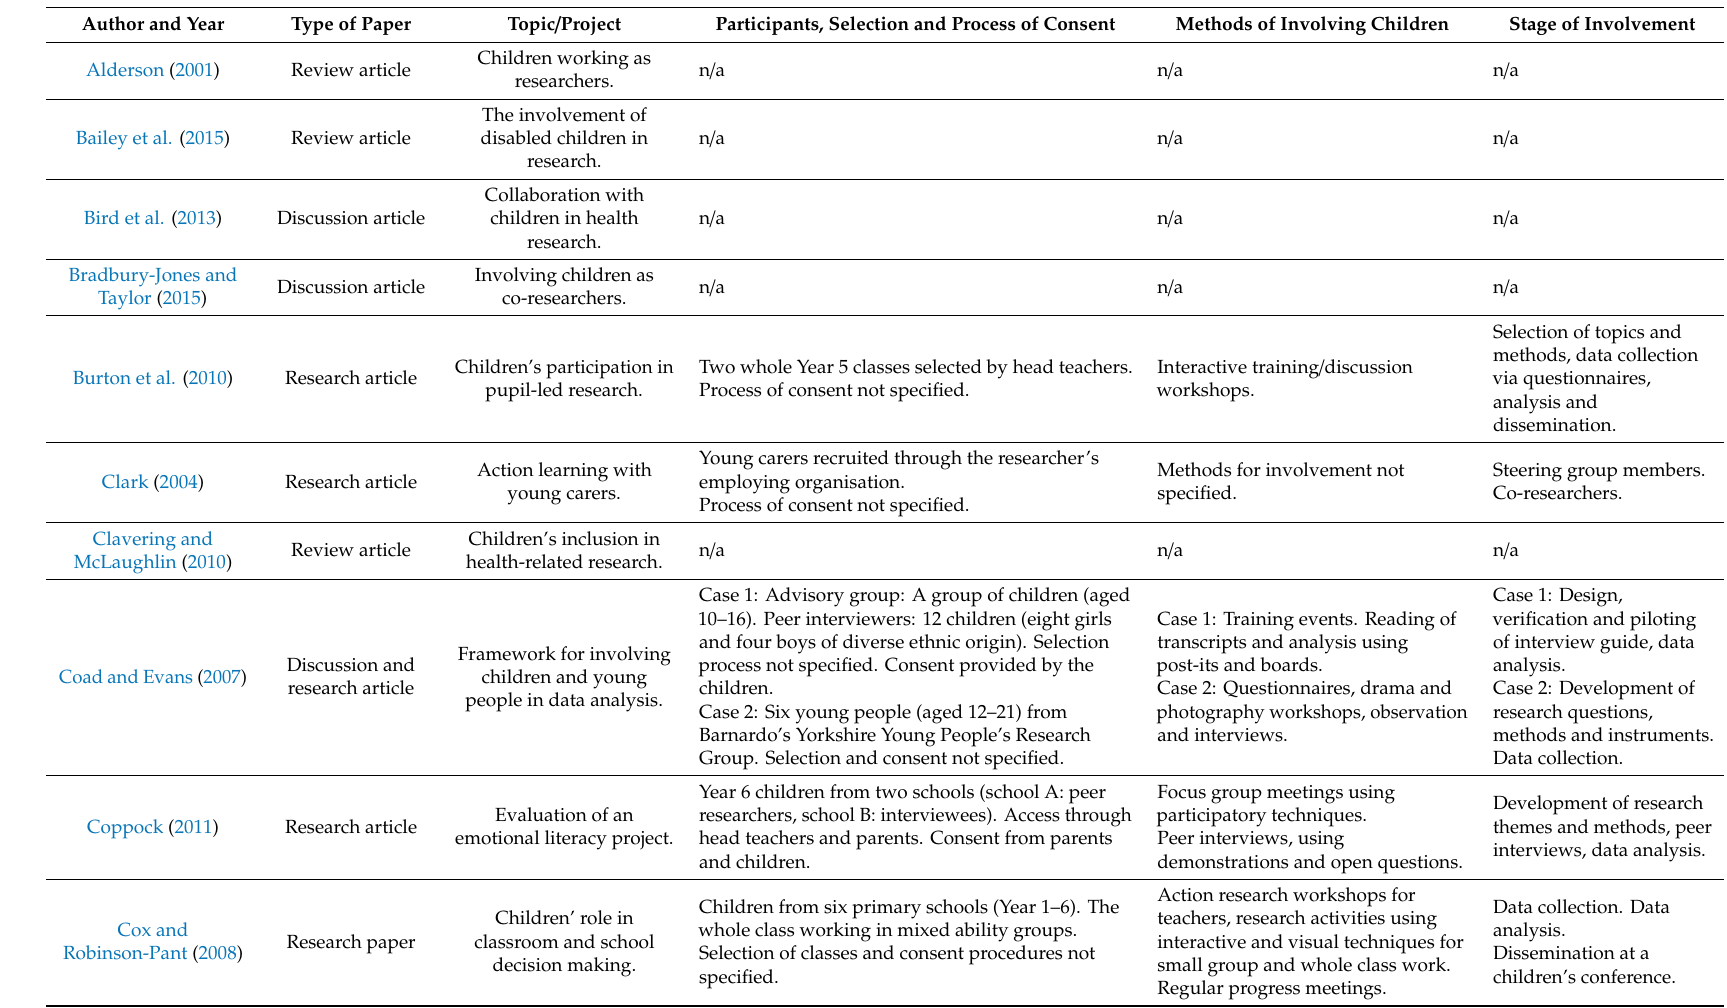
Table 1. List of papers included in the